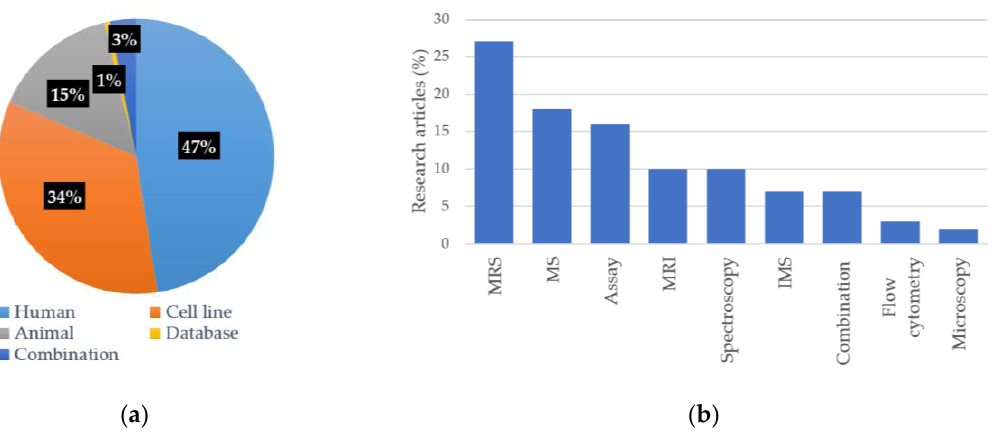
Figure 2. Number of research articles is based on: ( a ) different biological specimens; ( b ) various analytical techniques.